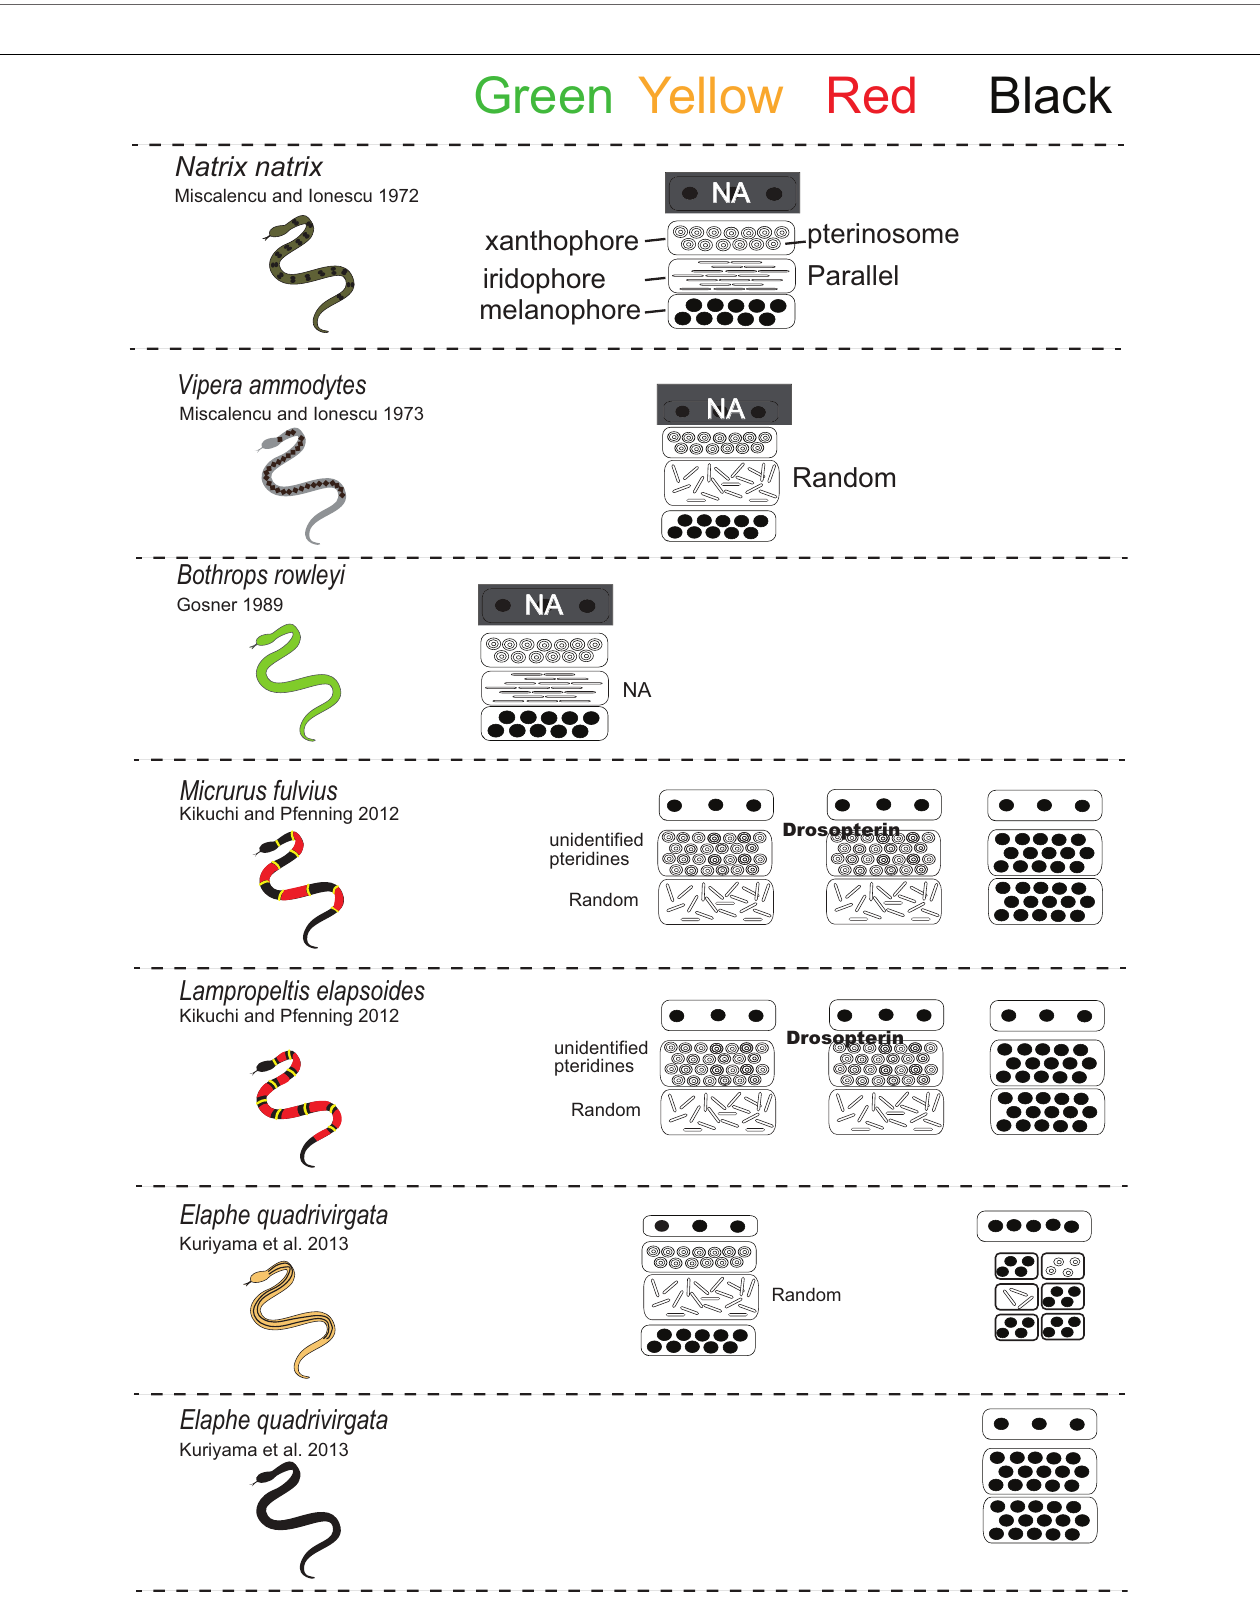
FIGURE 3 | A schematic drawing of the vertical combination and relative thickness of epidermal and dermal pigment cells producing different skin coloration in snakes.